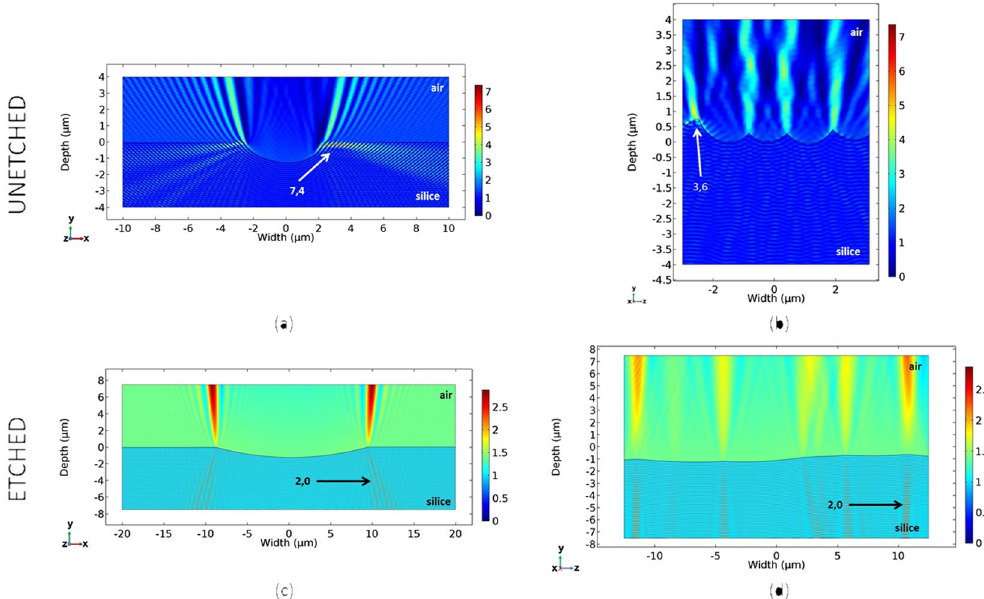
Figure 9. Evolution of the intensity (E²) distribution on an AFM cross-section perpendicular (( a ) and ( c )) or centered parallel (( b ) and ( d )), before (( a ) and ( b )) and after (( c ) and ( d )) a 12 µ m HF/HNO 3 wet etch. 2D finite- element modeling in TE polarization. Maximal intensity is decreased by the deep wet